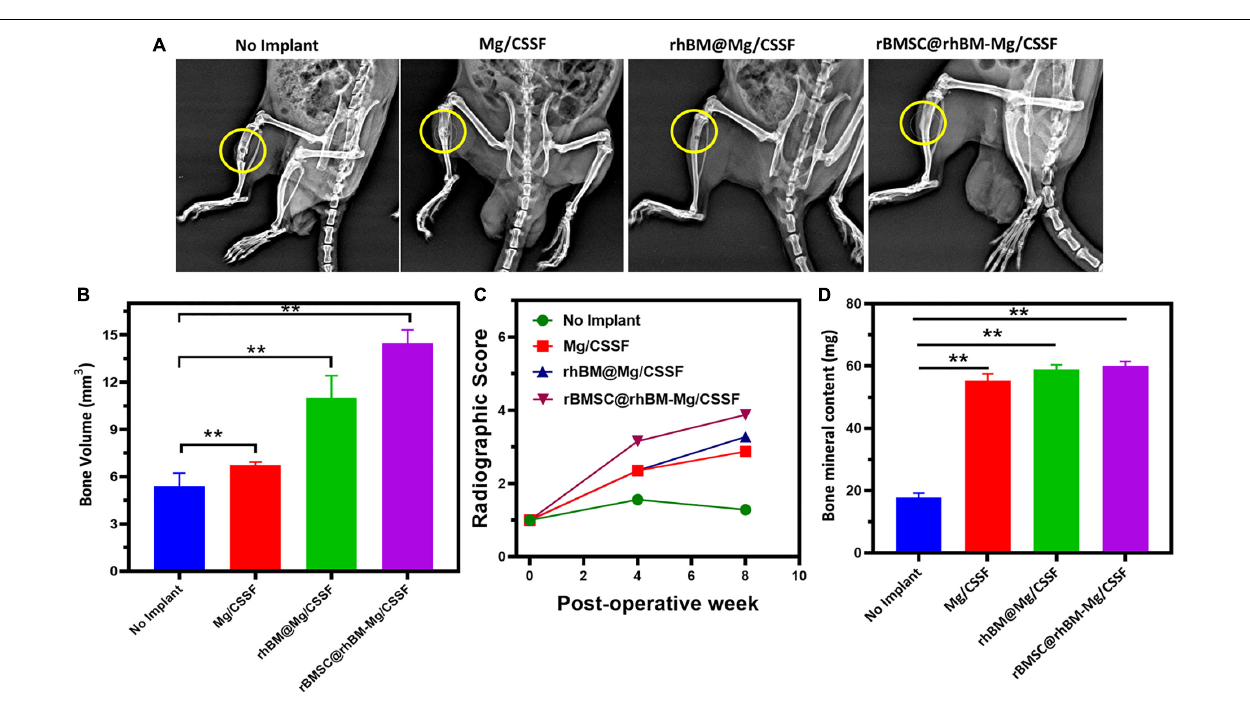
FIGURE 8 | (A) Radiography (x-ray) observation of femoral defects in RD rat models transplanted with rBMSCs encapsulated rBMSC@rhBM-Mg/CSSF and other comparative hydrogel groups (no implant defect models considered as control). Quantitative investigations of (B) bone volume (mm 3 ), (C) radiographic score, and (D) bone mineral content (BMC) on hydrogel treated in vivo models. ** p =